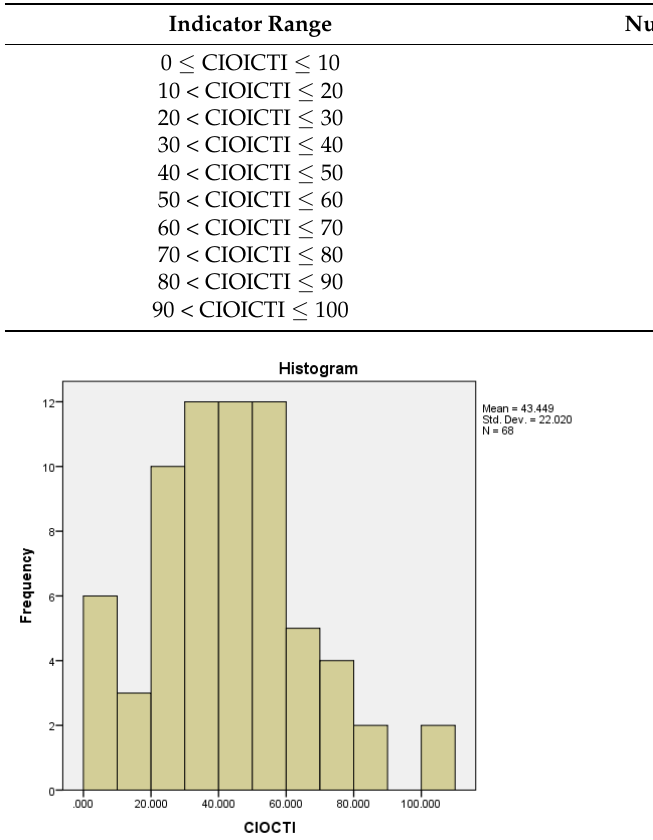
Table 12. Tests of